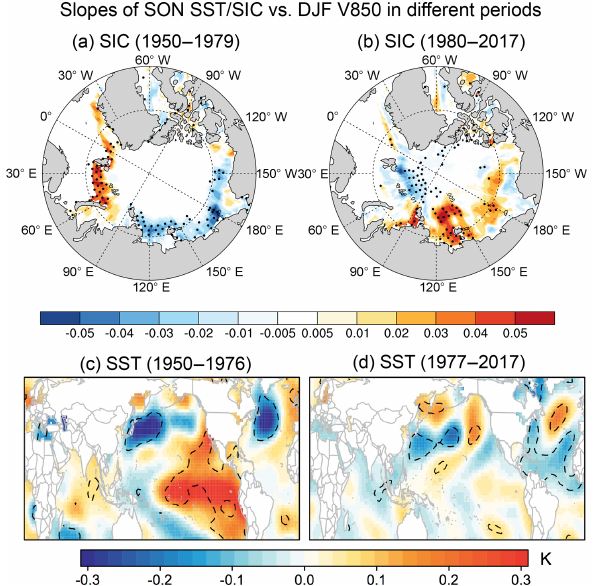
Figure 4. Multidecadal shifts in the relationships between the meridional wind over northern China in winter (V850) with sea ice concentrations (SICs) and sea surface temperatures (SSTs) in the preceding autumn (SON). The regression slopes of SON SICs vs. normalized DJF V850 during (a) 1950–1979 and (b) 1980– 2017 are shown. Grid boxes with statistically significant correla- tions ( p < 0 . 1) are stippled. Panels (c–d) show the same for SSTs. The dashed contour lines enclose regions in which correlations reach statistical significance ( p < 0 . 1). For all panels, data are de- trended by subtracting the 7-year moving average.